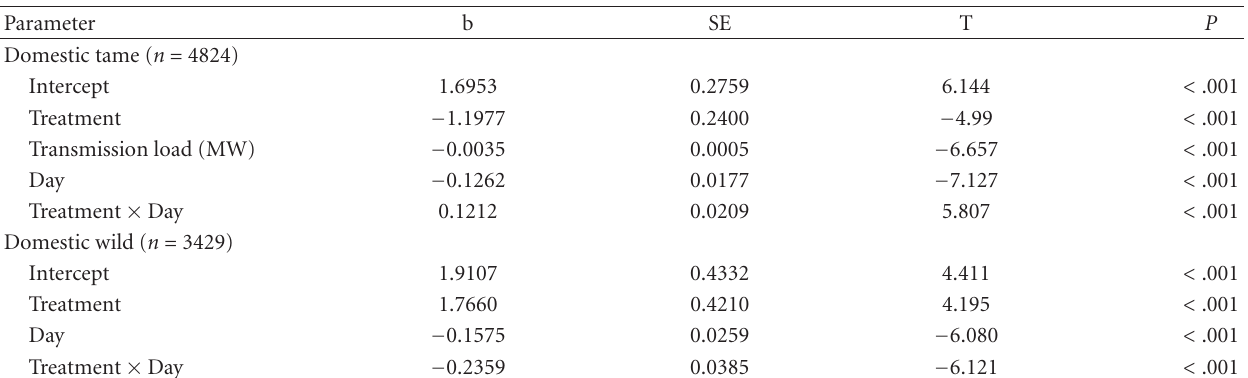
Table 4: Results from the best mixed logistic regression model of position (proportion of observations when an animal is in the lower half of the enclosure (zones 3 and 4)) of two trials with 12 domestic reindeer each. Animals of di ff erent degrees of tameness were tested separately. Intercept in all models is the estimate for zone 1 in a control enclosure. The model uses a logit-link.